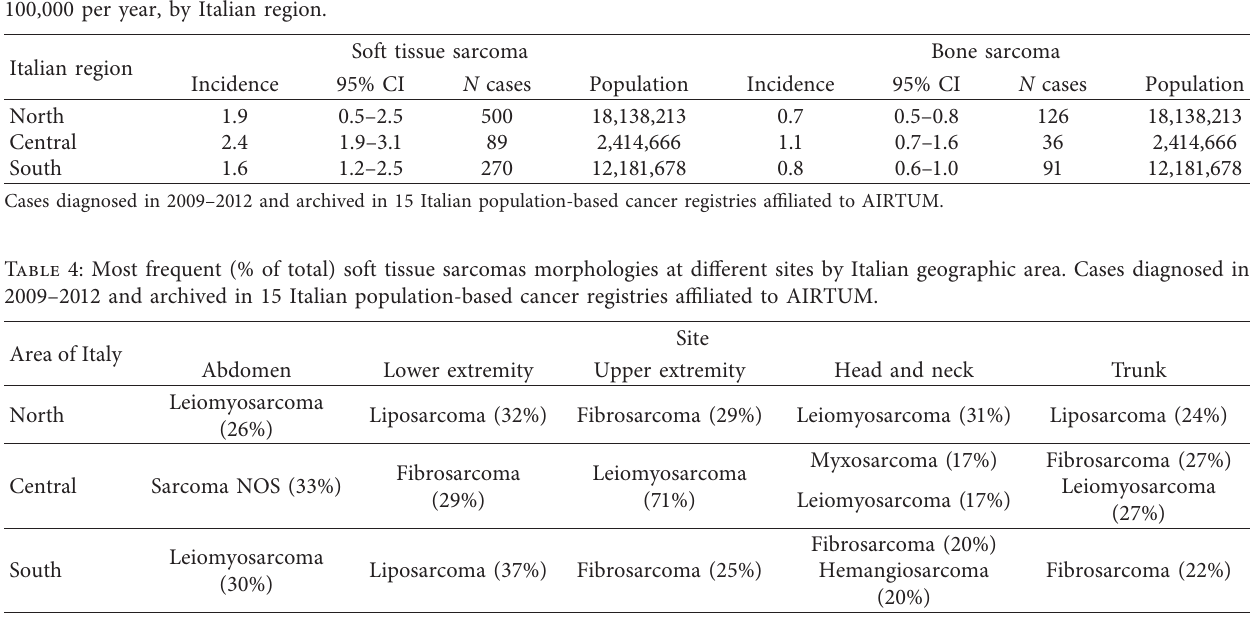
Table 5: Most frequent (% of total) bone sarcoma morphologies at different sites by Italian geographic area. Area of Italy